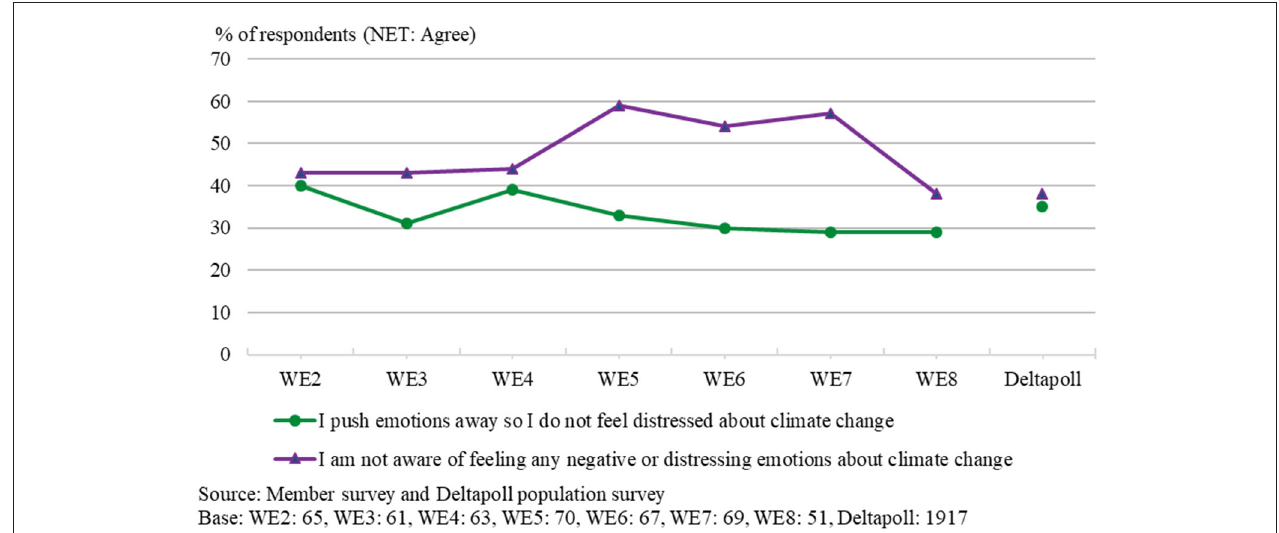
FIGURE 4 | Assembly members and public regulation of climate